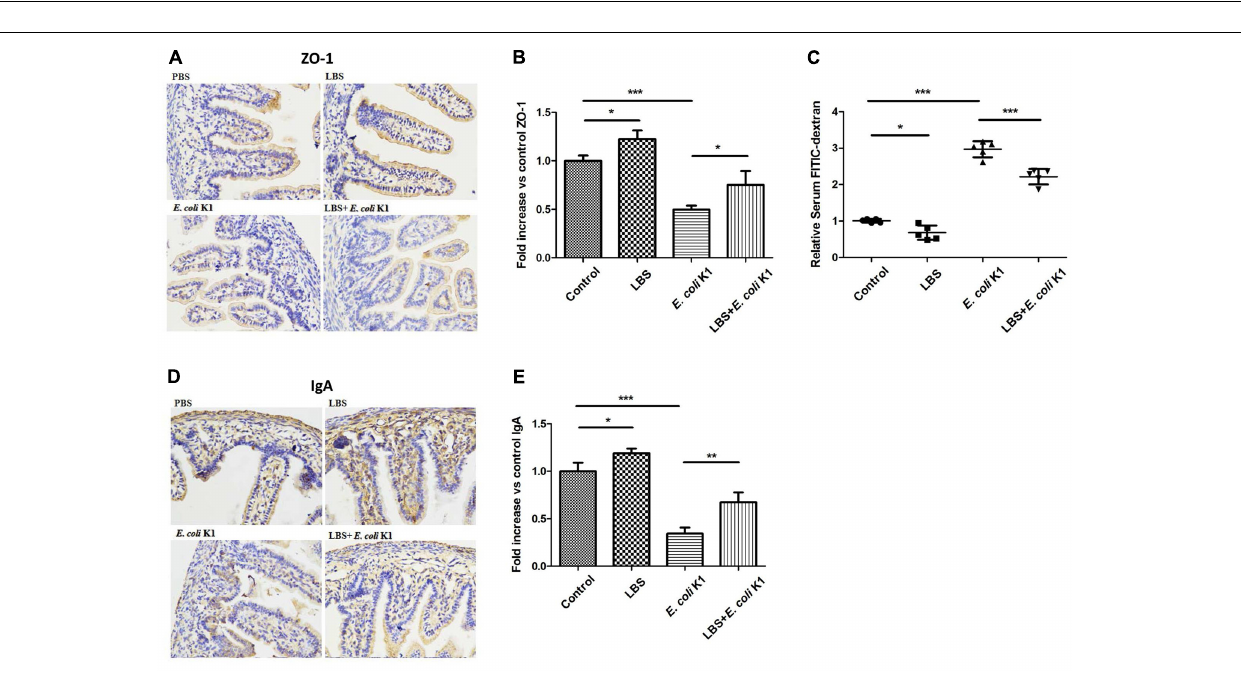
FIGURE 5 | Effects of LBS on mucin expression of neonatal colon tissue with or without E. coli K1 infection. Two days old neonatal rats were orally administered with or without LBS for 3 days before E. coli K1 infection. Pups administered with PBS or LBS alone was served as controls. (A) Colon tissues received different treatment were processed with PAS stain and visualized by light microscopy (200 × magnification). (B) The number of PAS-positive cells was calculated. Results are represented as mean ± SD. ∗ P < 0.05, ∗∗ P < 0.01.